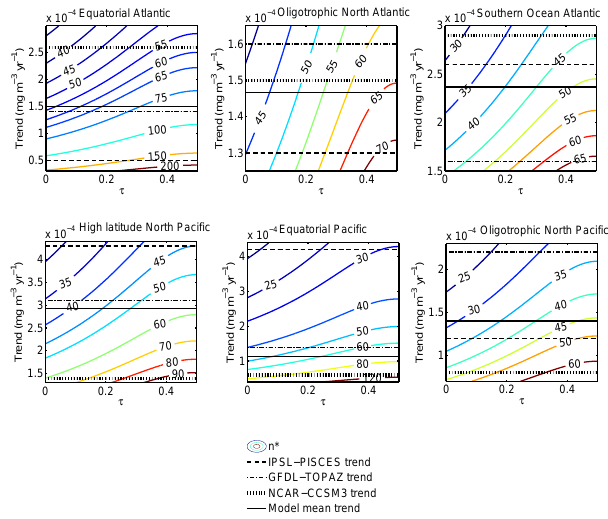
Fig. 5. Number of years of observations ( n ∗ ) necessary to detect a trend in satellite monthly ocean chlorophyll in six different biomes according to the magnitude of the trend and of the fraction of data before the discontinuity ( τ ). The standard deviation and autocorre- lation used in the calculations were estimated from SeaWiFS data from 1998–2007. The range for the trend magnitude was obtained from three biogeochemical models, and these magnitudes (in abso- lute value) are shown on the figure as well as the model mean trend (Table 2). We present the fraction of data before the discontinuity between 0 and 0.5 only since the results are symmetric. For exam- ple, the number of years necessary to detect a trend of the same magnitude will be the same if the discontinuity occurs after 25% or 75% of the data were collected.